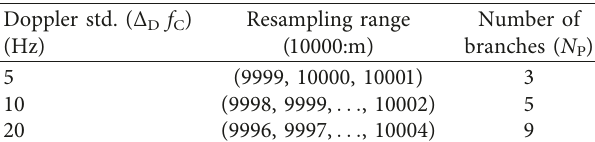
Figure 10: Block diagram of parallel resampling receiver. (a) Transmitter, (b) receiver, and (c) OFDM demodulation. Table 5: Examples of resampling ratios and number of